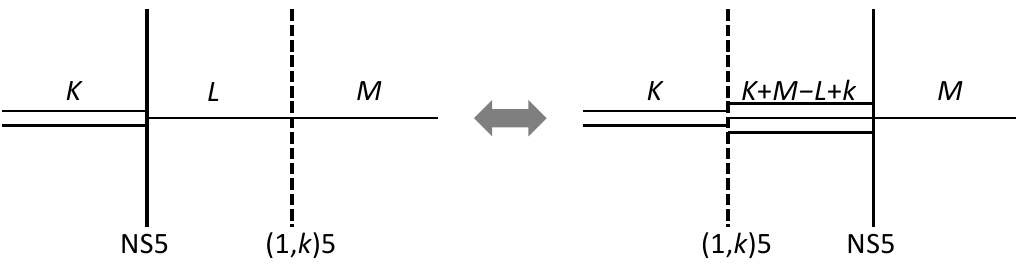
Figure 2 . The Hanany-Witten transition of our main interest in this paper. In the following we often denote the brane con(cid:12)guration by (cid:1) (cid:1) (cid:1) K (cid:15) L (cid:14) M (cid:1) (cid:1) (cid:1) ’ (cid:1) (cid:1) (cid:1) K (cid:14) ( K + M (cid:0) L + k ) (cid:15) M (cid:1) (cid:1) (cid:1) for simplicity, where (cid:15) is an NS5-brane and (cid:14) is a (1 ; k